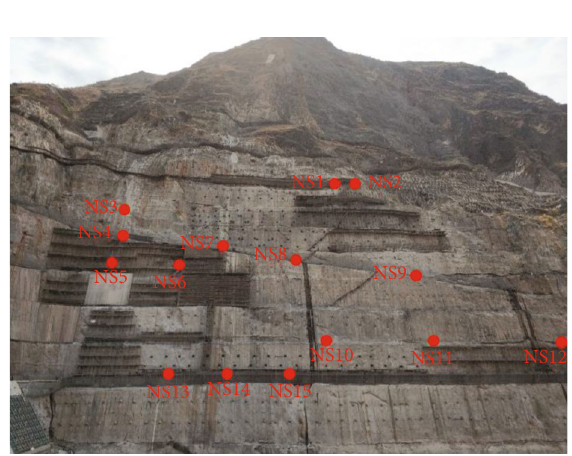
Figure 14: Layout of on-site monitoring